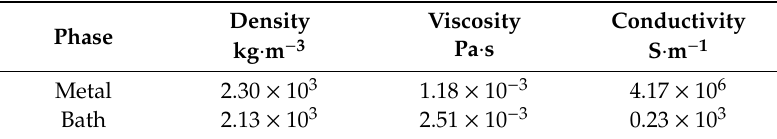
Table 1. Material